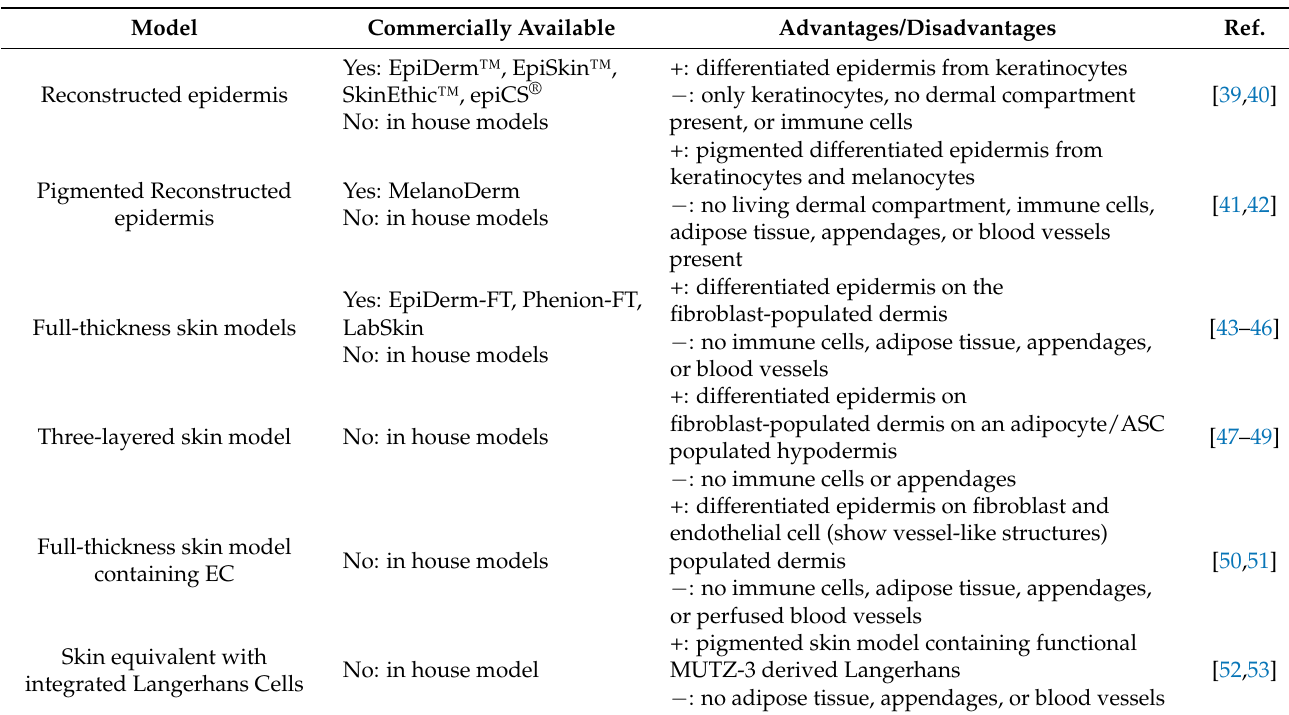
Table 4. An overview of tissue-engineered 3D skin models from human primary cells and their limitations (from Broek et al., 2017